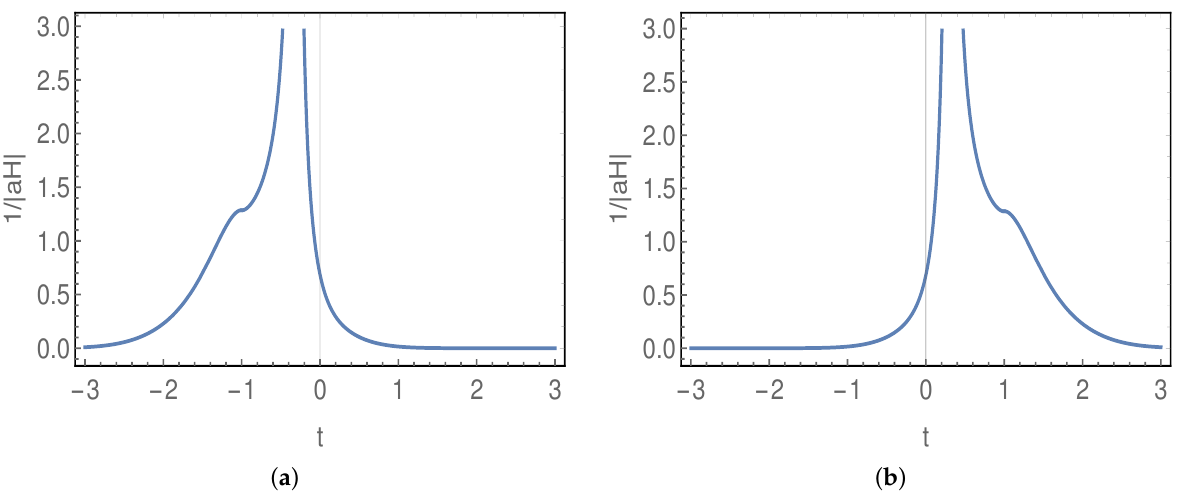
Figure 1. r h ( t ) vs. t . The left and right plots correspond to t s = − 1 By and t s = 1 By, respectively. t 0 is taken as 1 By in order to use the unit of Billion year (By) for all the time coordinates. Therefore, in the left plot, t s < t b = − 0.31 By, and in the right plot, t s > t b = 0.31 By. Here, we take n = 0.3, a 0 = 4, α = 5/3, and f 0 = 1. It can be seen that the observable quantities, in the case when the Type-IV singularity globally affects the spacetime, are not compatible with the Planck data. Hence, in order to present the plots, we consider a set of values for the parameters by keeping the following points in + 1 mind: ( a ) the value of α should satisfy the form of α = 2 p , as we mentioned after Equation (22), 2 q + 1 and ( b ) the parameter n should be less than 1 , so that the comoving Hubble radius predicted by 2 a 1 ( t ) diverges to infinity in the distant past and realizes the effects of the Type-IV singularity on the bouncing dynamics. Thus, for example, we consider n = 0.3, a 0 = 4, α = 5/3, and f 0 = 1—which, in fact, leads to the viability of the bounce model when the Type-IV singularity locally affects the spacetime (see Section